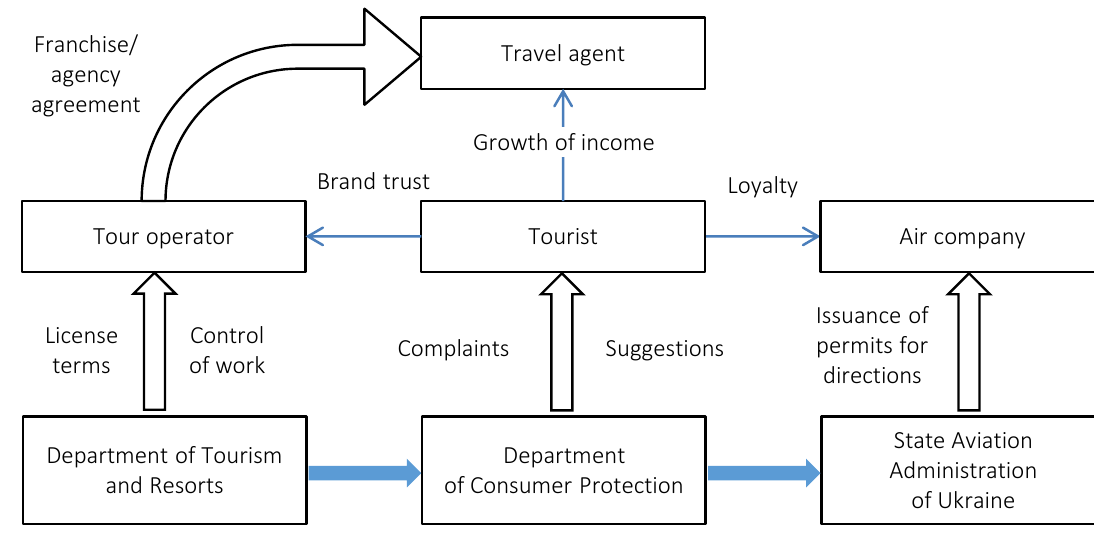
Figure 6. Interconnection of the actors of the charter air transportation